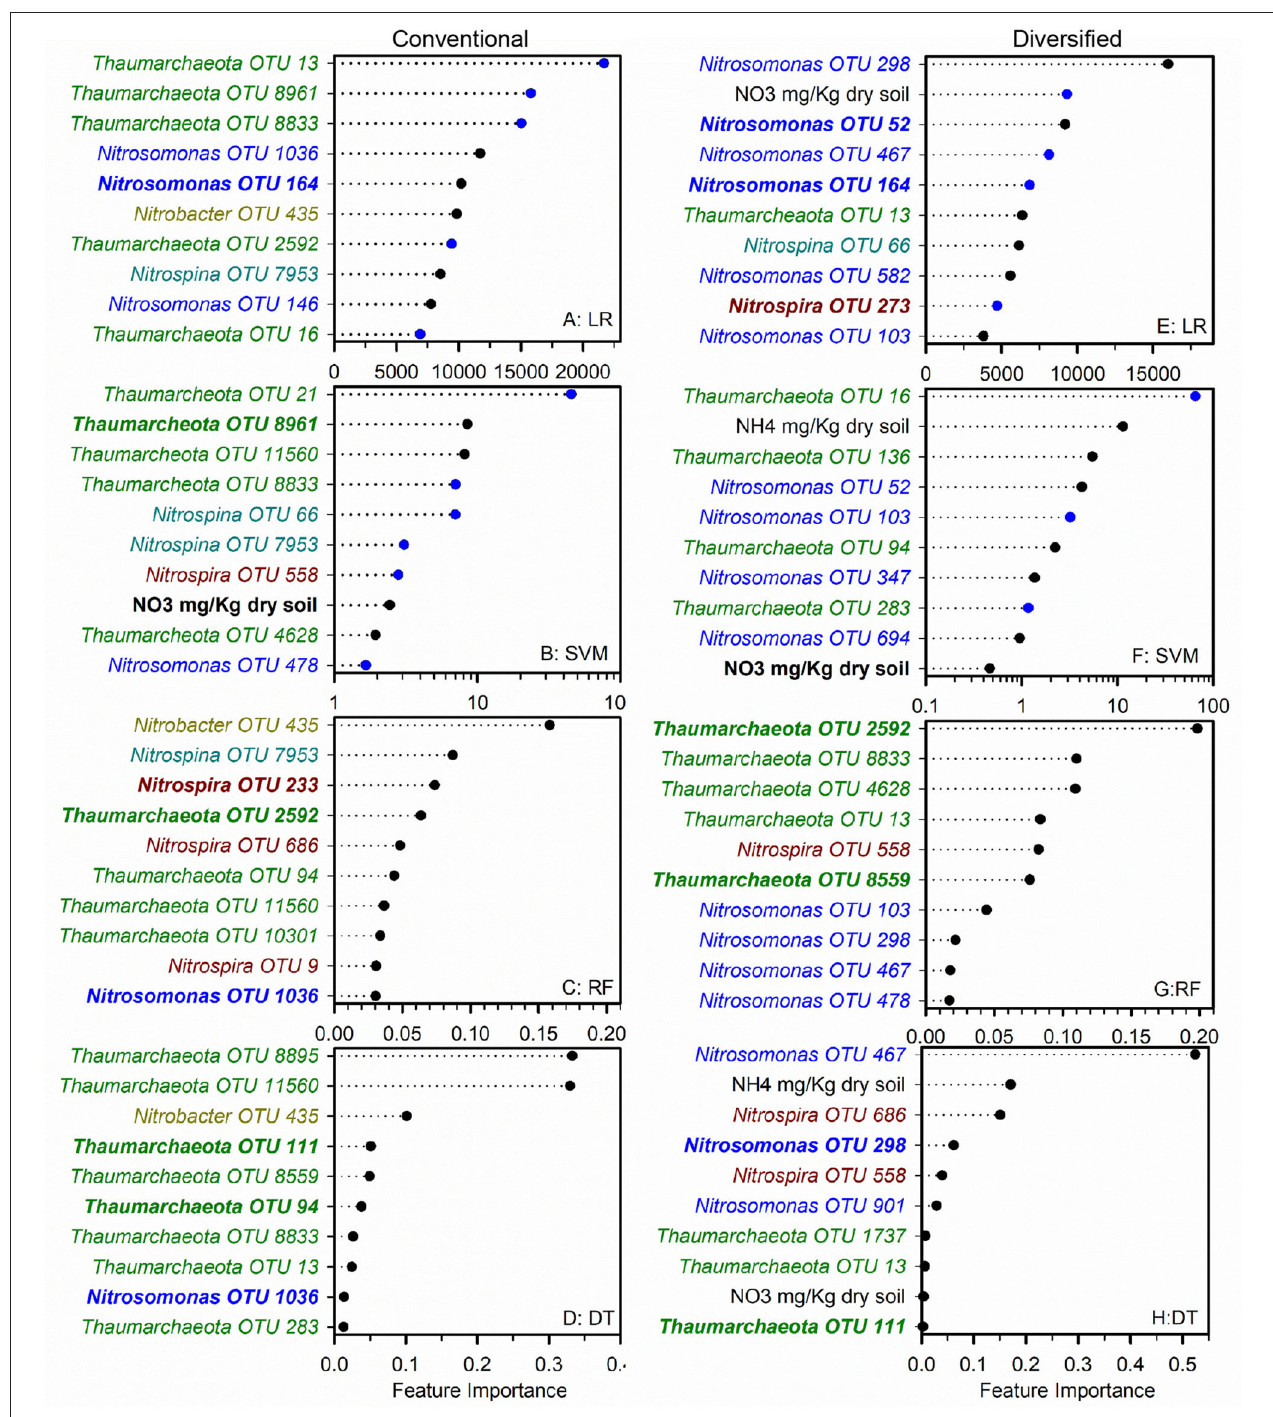
FIGURE 5 | Ranks of absolute feature weights of linear (A,B,E,F) and nonlinear (C,D,G,H) models for each cropping system. The 10 highest ranked features of absolute feature weights are displayed from highest to lowest. In regression (A,E) and SVM (B,F) , feature importance of OTUs positively associated with nitrification are represented by black dots, and those negatively associated with nitrification are shown in blue. The values for linear regression are the absolute feature importance, while for SVM, the log 10 relative absolute feature importance. Within each model, bold OTUs indicate the same OTUs in both cropping systems. Random Forest (C,G) . Decision Tree (D,H)